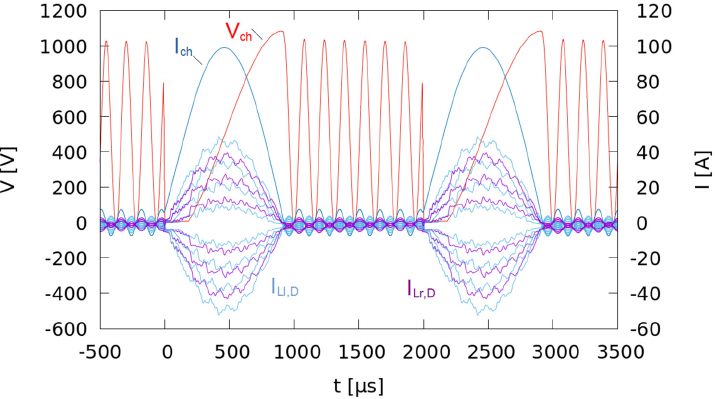
Figure 18. Distribution of the charging current along the charging path according to the position in the generator for an on-time of the solid-state switches of 22 µs. The charging currents I Ll,D through the coils of the left four current-compensated chokes are shown in light-blue colour, and the charg- ing currents I Lr,D through the coils of the right three current-compensated chokes in violet colour. Thereby, the current decays stepwise from the centre towards both ends of the generator. V ch and I ch denote the charging voltage and the charging current at the generator’s input terminal, respec- tively.